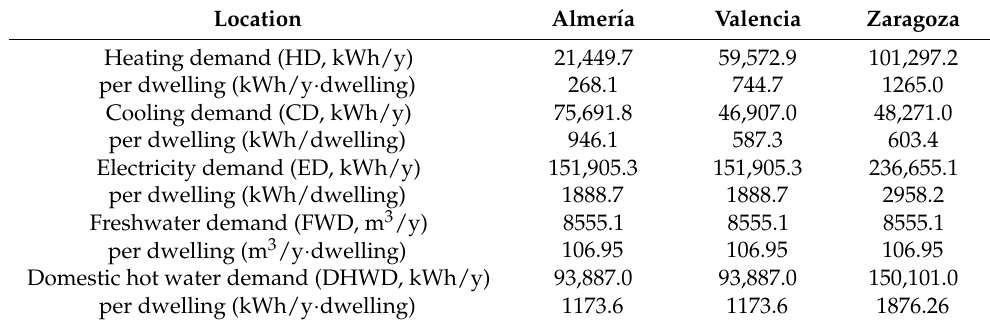
Table 3. Annual energy and water consumption for the same building in the three selected